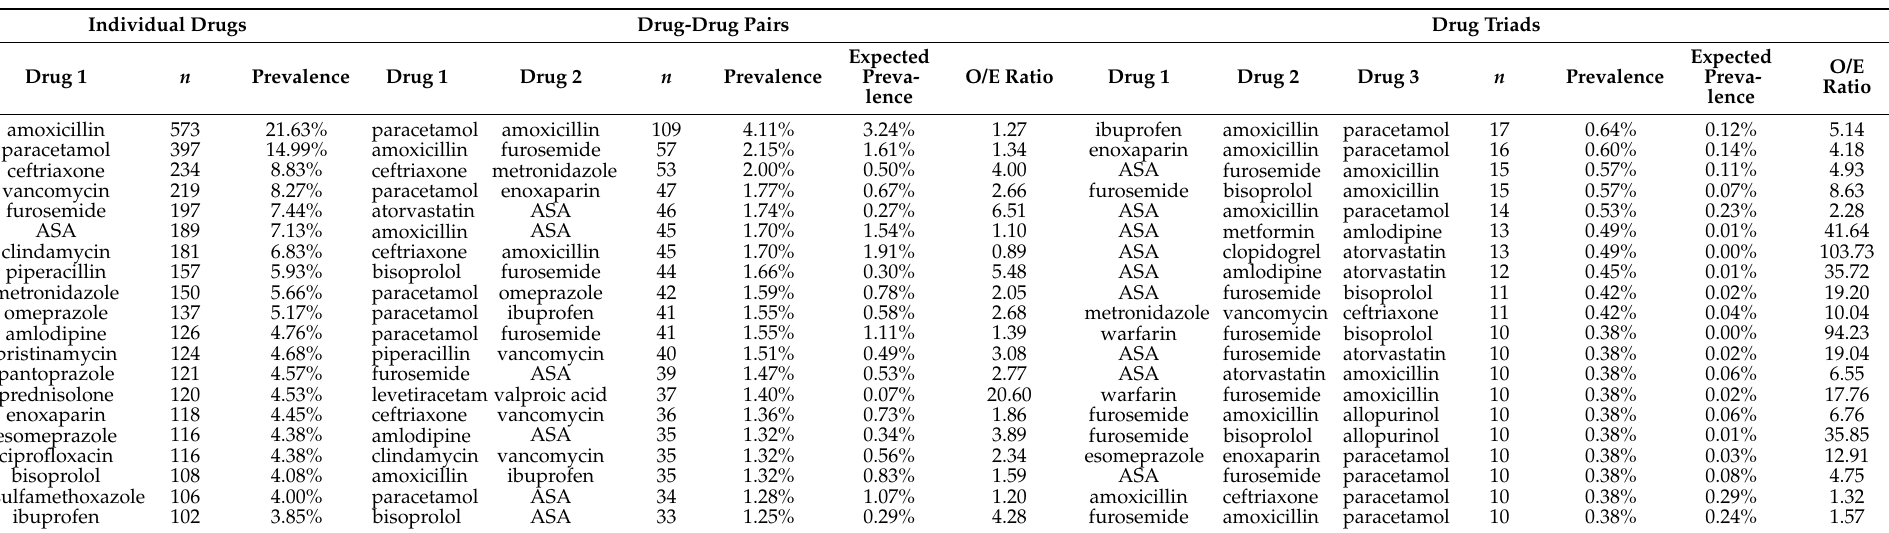
Table 2. Most frequent drugs for the 2649 ICSRs included in the network